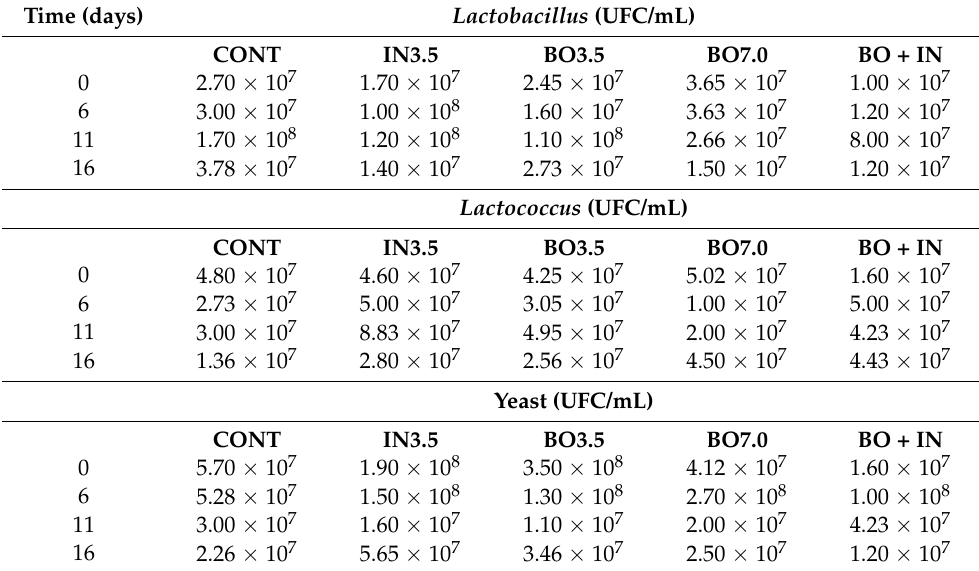
CONT, without adding ingredients; IN3.5, with the addition of 3.5% inulin ( m / v ); BO3.5, with the addition of 3.5% bocai ú va powder-pulp ( m / v ); BO7.0, with the addition of 7.0% bocai ú va powder-pulp ( m / v ); and BO + IN, addition of 3.5% inulin + 3.5% bocai ú va powder-pulp. Different letters indicate a statistical difference between the fermented beverages during the shelf life by the Tukey test ( p < 0.05).